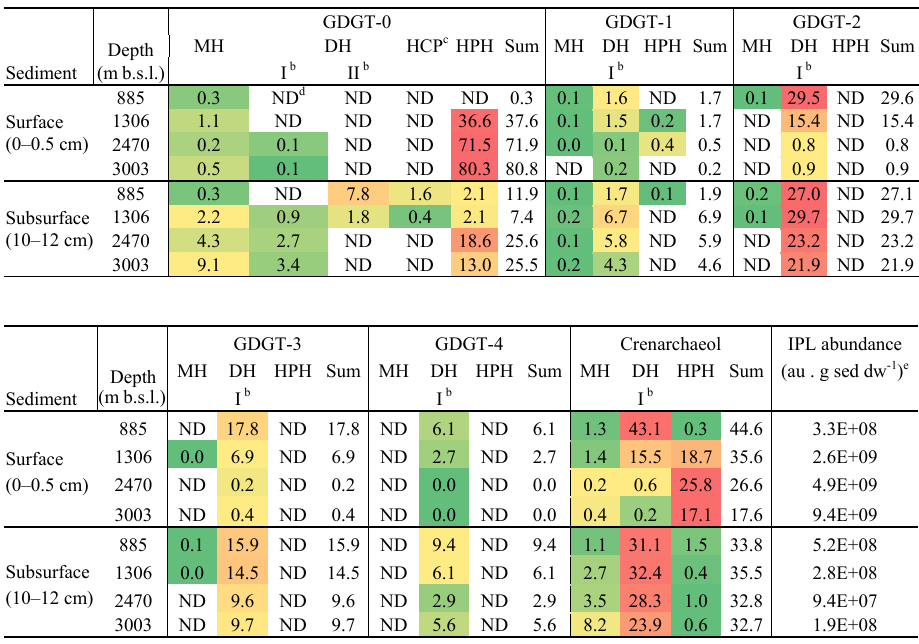
Table 2. Total IPL abundance and heat map a of the relative abundance (%) of the detected IPLs and sum (not color coded) per IPL-GDGT in the sediments studied. GDGT-0 GDGT-1 Depth Sediment (m b.s.l.)